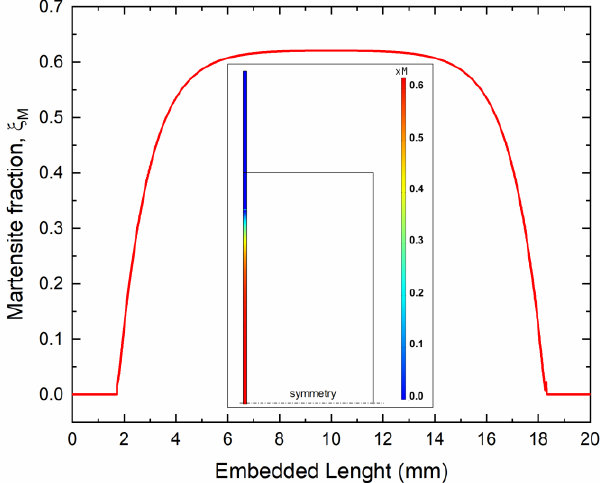
Figure 13. Martensite fraction in the SMA wire after thermal activation (i = 1.12 A) as obtained from finite element simulations.